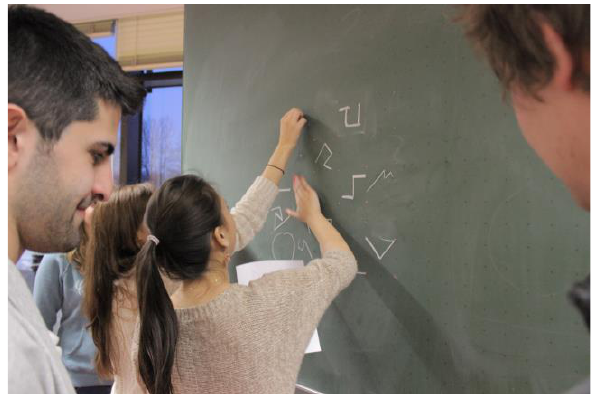
Figure 6. Students analyzing Mohr's "A formal language". University of Bremen